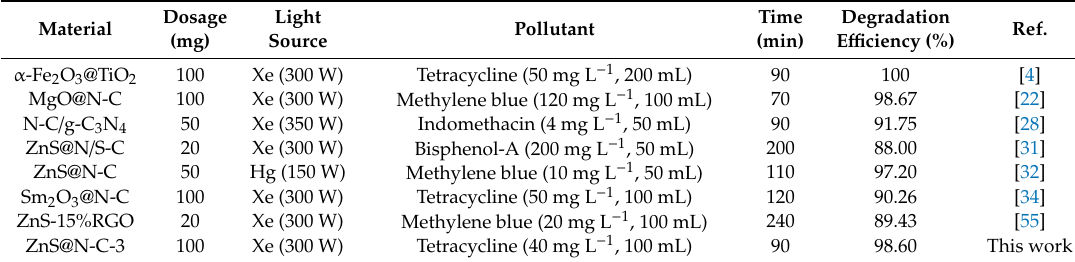
Figure 8. Photocatalytic activity of ZnS and ZnS@N-C composites ( A ), effect of pH value on the photocatalytic capacity of ZnS@N-C-3 ( B ), photocatalytic durability of ZnS@N-C-3 ( C )for five cycles, and quenching testing of ZnS@N-C-3 ( D ) for tetracycline hydrochloride (TCH) removal. Table 2. Comparison of the degradation rate of various materials towards pollutants.